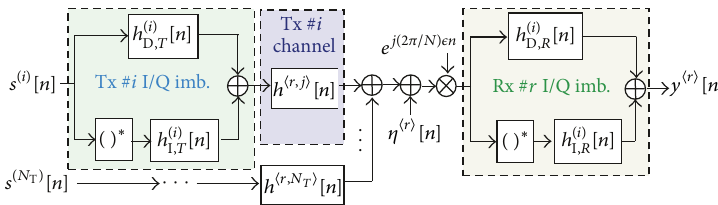
Figure 2: Equivalent baseband model with CFO and I/Q imbalance.